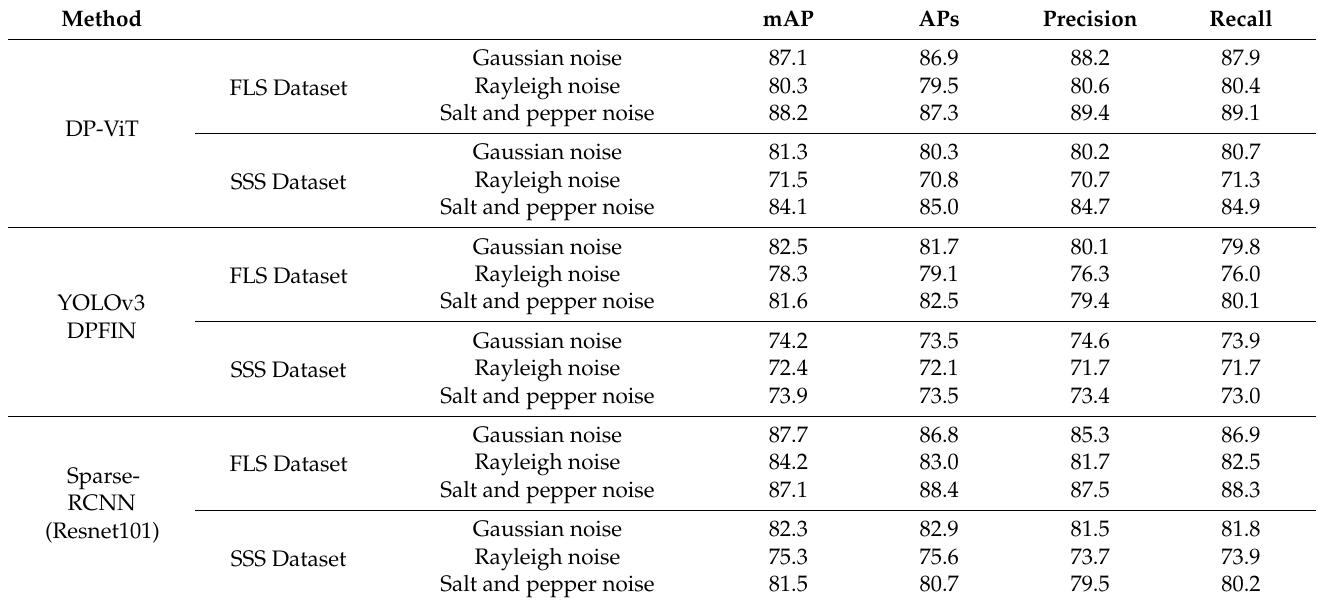
Figure 10. Schematic diagram of adding noise to side-scanning sonar image and front looking sonar image. ( a ) Real image ( b ) Gaussian noise ( c ) Rayleigh noise ( d ) Salt and pepper noise.